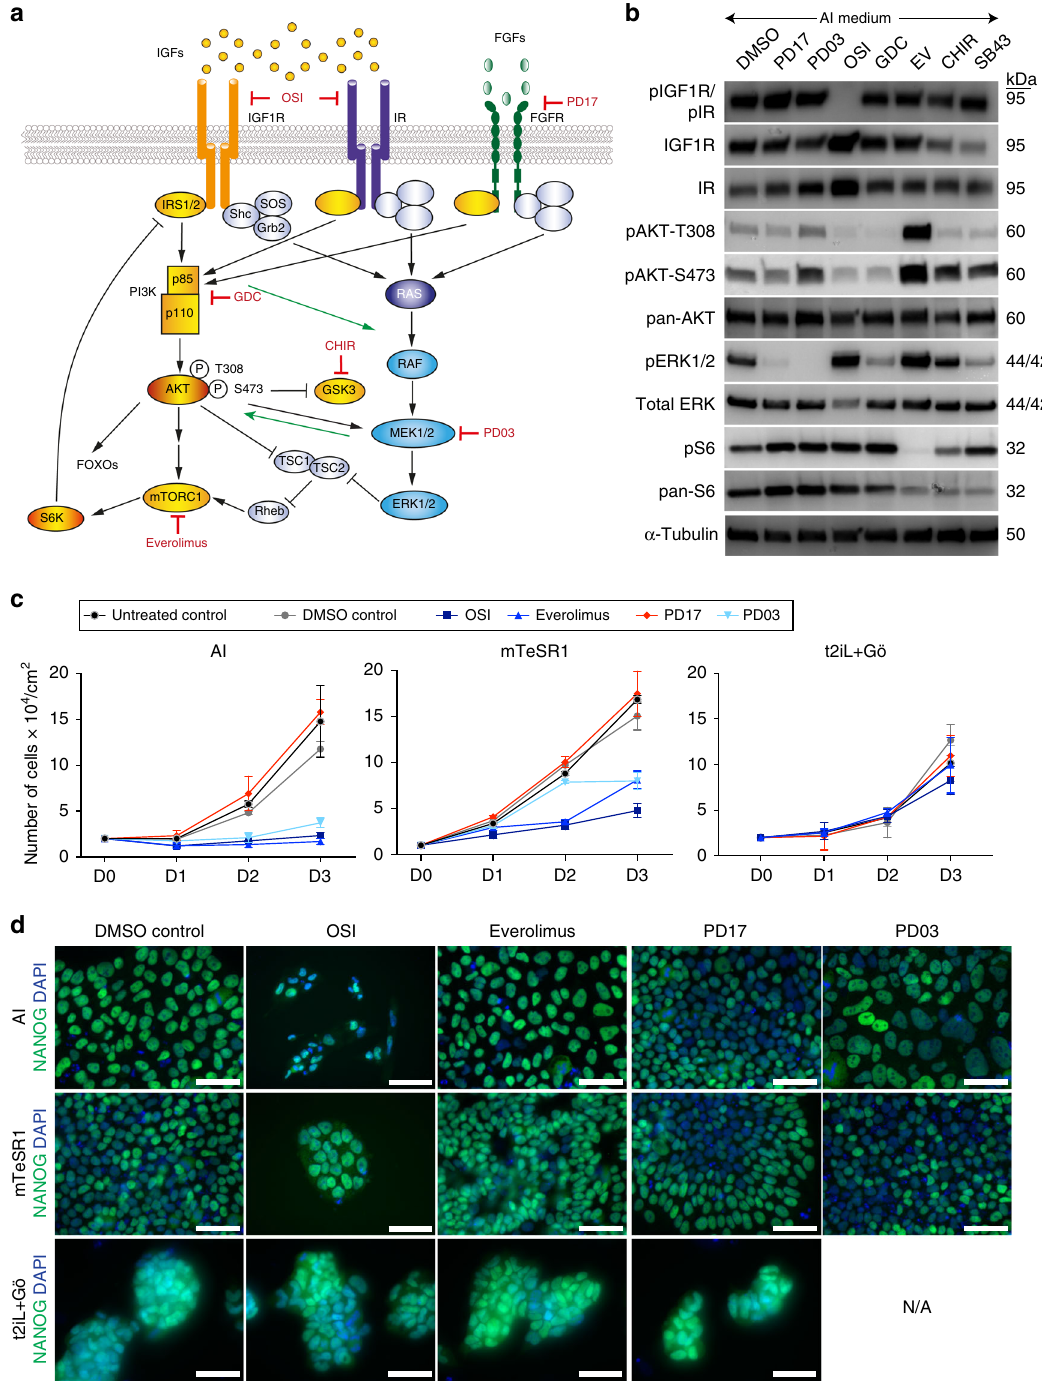
Fig. 3 Insulin/IGF1R/PI3K/mTOR and MAPK/ERK signalling pathways are active in both conventional and naïve hESC culture conditions. a Schematic of the crosstalk between the insulin/IGF1 and receptor tyrosine kinase (RTK) signalling pathways. Insulin receptor (IR), IGF1 receptor (IFG1R), IGF binding proteins (IGFBPs), receptor tyrosine kinase (RTK), IGFR and IR inhibitor OSI-906 (OSI), FGF receptor tyrosine kinase inhibitor PD173074 (PD17), PI3K inhibitor GDC-0941 (GDC), GSK3 β inhibitor CHIR99021 (CHIR), MEK inhibitor PD0325901 (PD13), mTOR1 kinase inhibitor Everolimus (EV). b Representative western blot analysis for proteins related to PI3K/AKT/mTOR and MAPK/ERK signalling in hESCs cultured in AI medium supplemented with DMSO, PD17, PD03, OSI, GDC, EV, CHIR or the Activin/Nodal receptor inhibitor SB-431542 (SB43) for 24 h. n = 3 biological replicates. c Quanti fi cation of the total number of viable cells over 3 days in AI, mTeSR1 or t2iL + Gö media supplemented with DMSO, OSI, EV, PD17 or PD03. The value at each time point represents the mean of n = 2 biological and n = 4 technical replicates, and error bars represent s.e.m. d Representative immuno fl uorescence analysis for NANOG (green) expression in control or inhibitor-treated hESCs in AI, mTeSR1 or t2iL + Gö media, following 3 days of treatment. DAPI (blue) nuclear stain. Scale bar: 50 μ m. Source data are provided as a Source Data fi